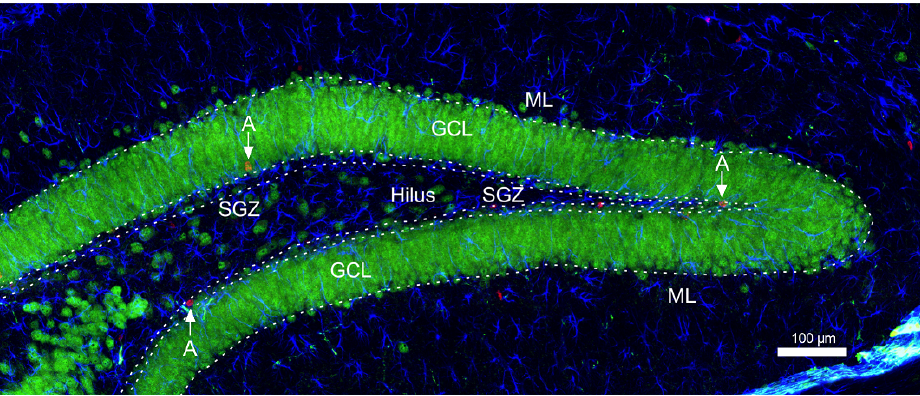
Figure 2. Scheme of areas of the hippocampal DG designated for quantitative analysis of